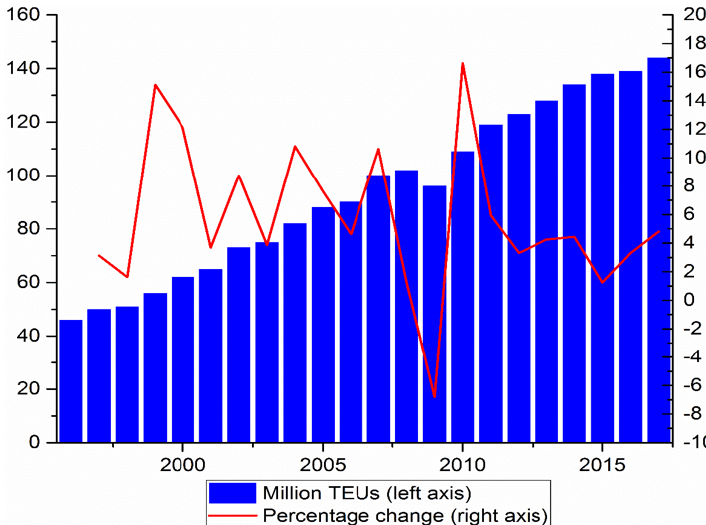
Figure 1. Global containerized trade in recent two decades (Millions TEUs and annual percentage change). Sources: By author based on the data from the Review of Maritime Transport